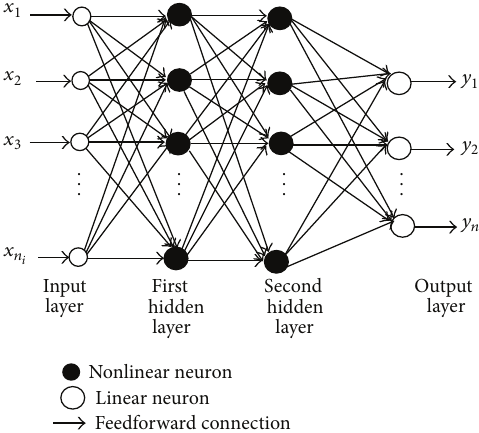
Figure 3: A layered feed-forward artificial